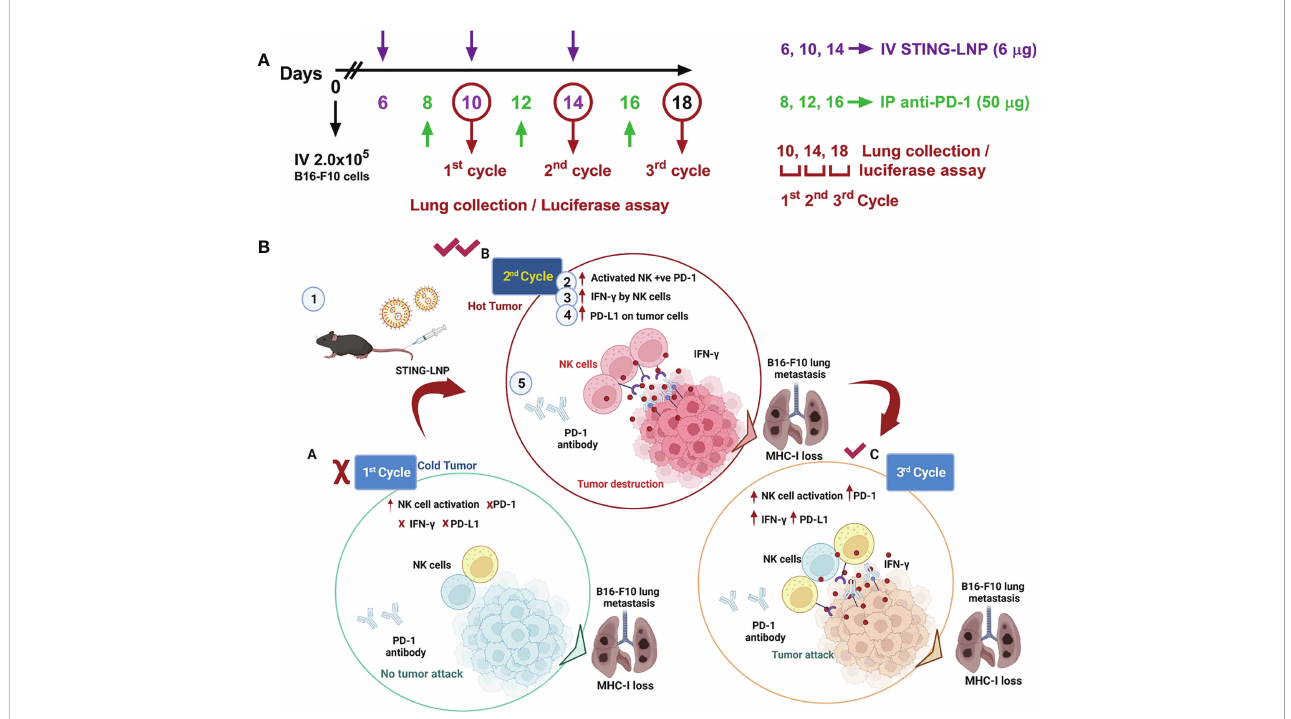
FIGURE 4 Interval- and cycle-dependent combination of CDG-loaded lipid nanoparticles with PD-1 antibody for tumor immunotherapy. (A) Treatment schedule for assessing the impact of dosing interval and cycle number. Cycles were counted from mice intravenously injected with B16-F10-Luc2 cells. PBS or the CDG-loaded STING-LNP were intravenously injected while the PD-1 antibody was injected intraperitoneally. (B) Tumor internal environment transformation and underlying mechanism behind the cycle-dependent combined activation of STING-LNP and PD-1 antibody in a lung metastasis model. Reproduced from Ref. (41) with permission. Copyright 2022